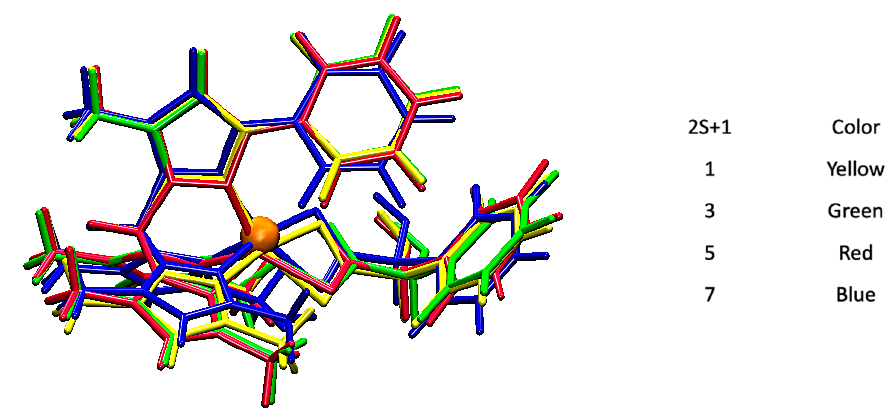
Figure 1. Superposition of the M06L optimized structures of model a at the different spin states considered.